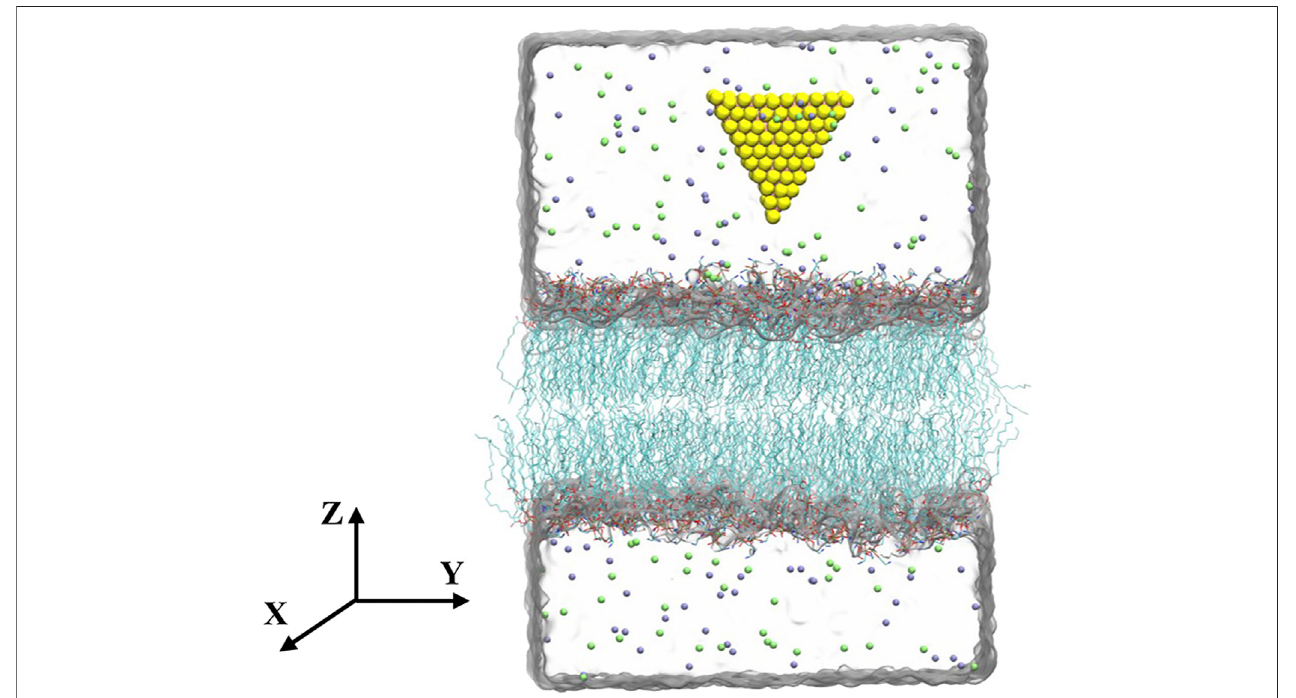
FIGURE 1 | Initial con fi guration of the simulation system. Molybdenum and sulfur atoms are shown as pink and yellow spheres, respectively. The lipids are in the licoricerepresentation.Thecarbonatomsareshownincyan,oxygenatomsinred,phosphorusatomsinblue,nitrogenatomsinbrown.Waterisshowntransparentlyfor clarity. Sodium and chlorine ions are displayed by green and purple spheres, respectively.